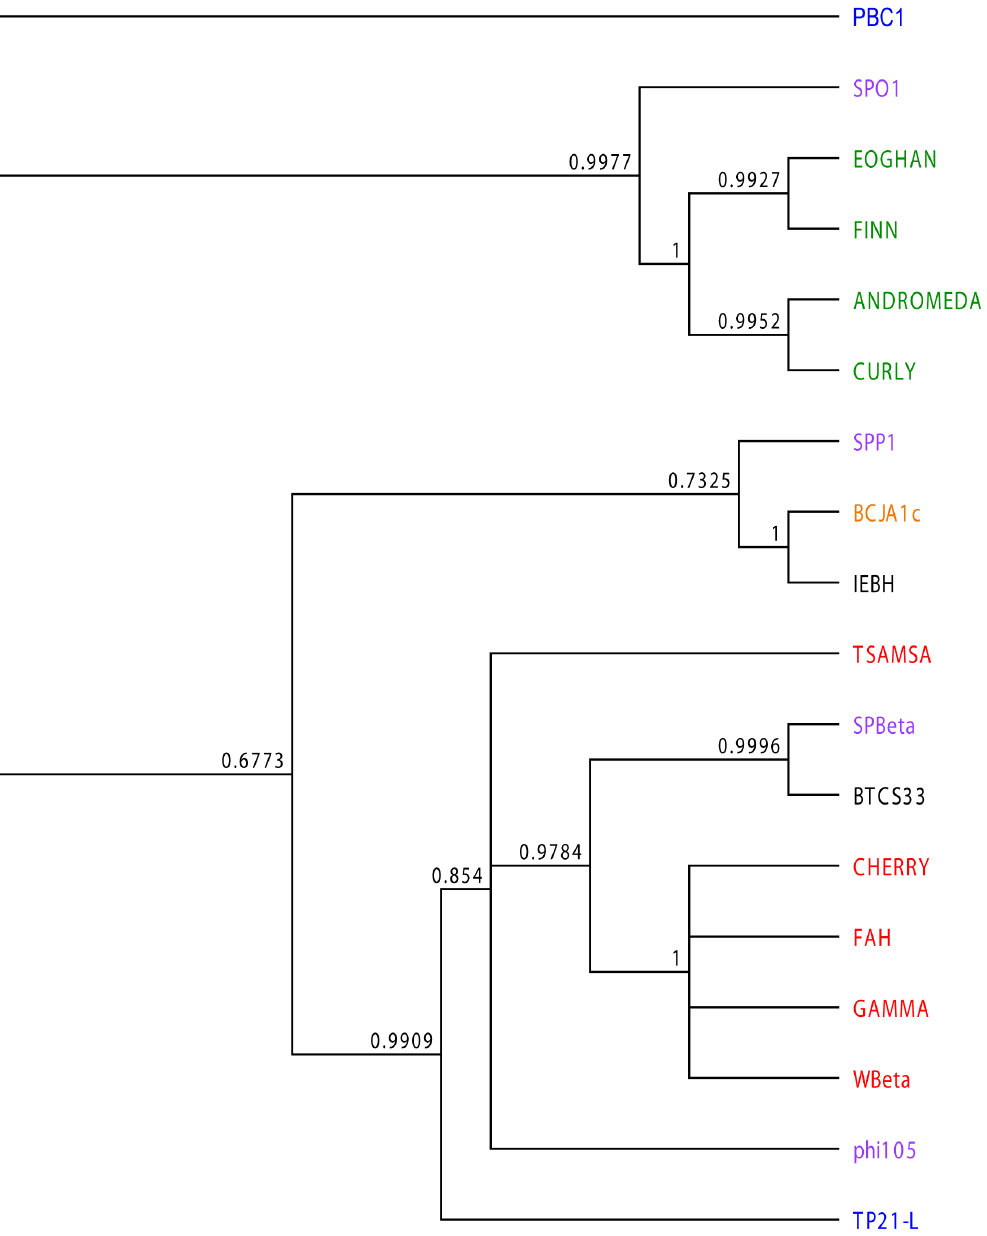
Figure 4. Phylogenetic relationship of the large terminase subunit gene in 18 Bacillus phages. Phages are color coded according to their host bacterium: B. anthracis in red, B. cereus in blue, B. clarkii in orange, B. pumilus in green, B. subtilis in purple and B. thuringiensis in black. The tree and posterior probabilities were determined from 1.1x10 6 generations with MrBayes 3.1.2 [22,23].